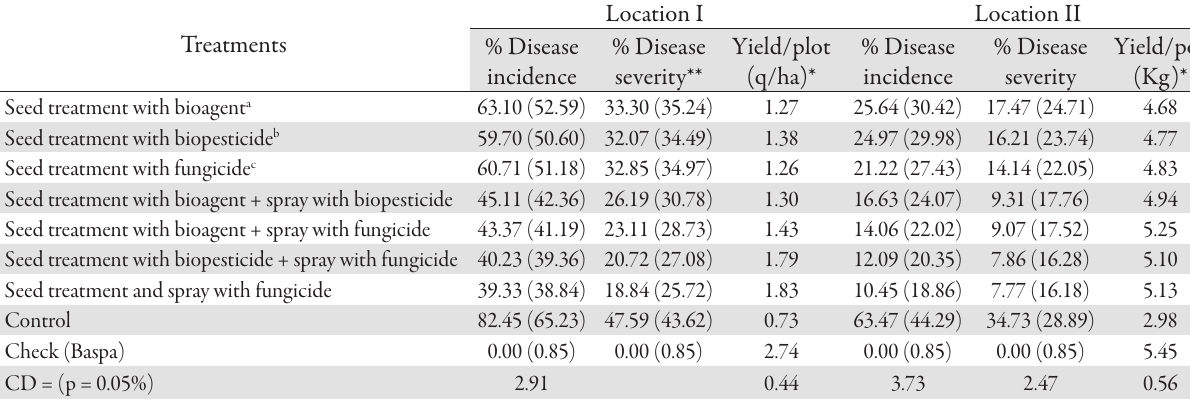
Tab. 3. Integrated management of bean anthracnose under field conditions